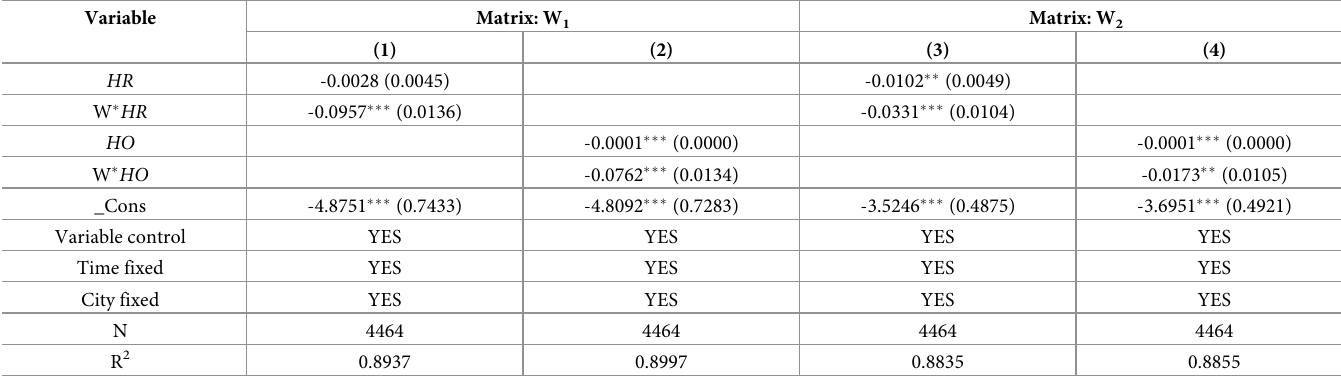
Table 9. SDID model estimation